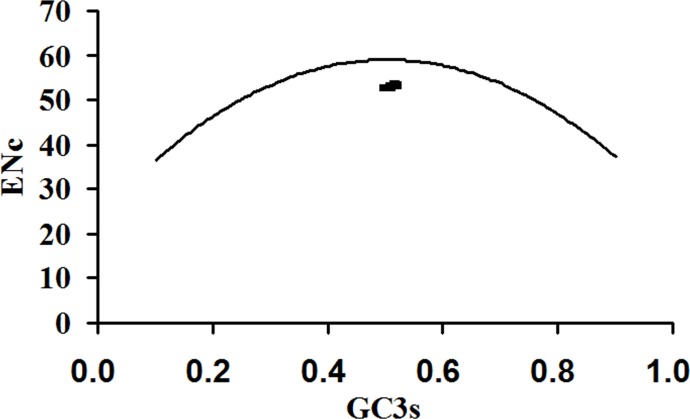
Graph showing the relationship between GC3s and effective number of codon (ENc) for the polyprotein-coding regions of ZIKV.The solid curve shows the expected ENc value if the codon usage is only determined by the variation in the GC3s.